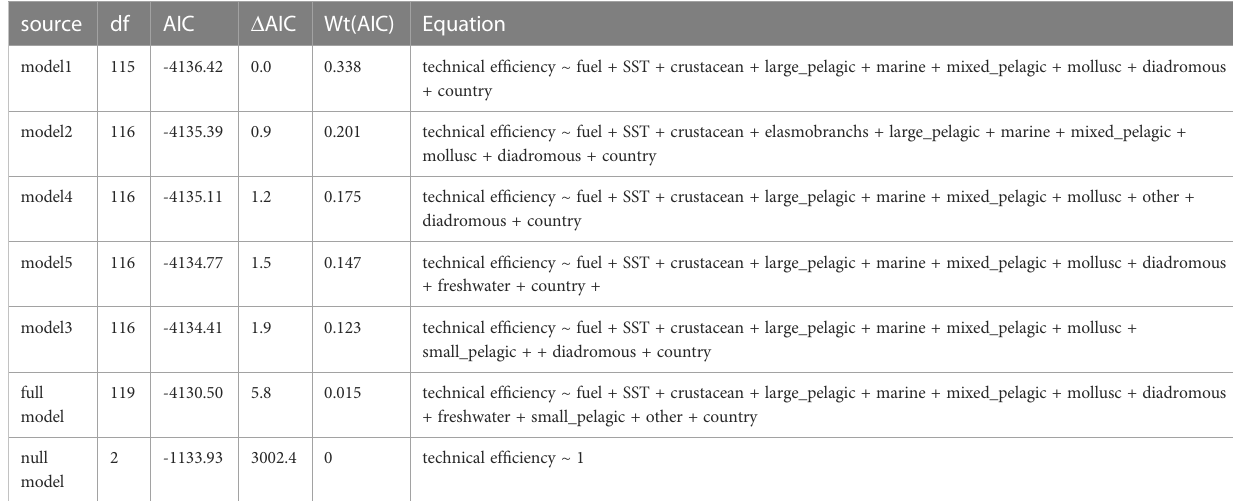
TABLE 2 Candidate models